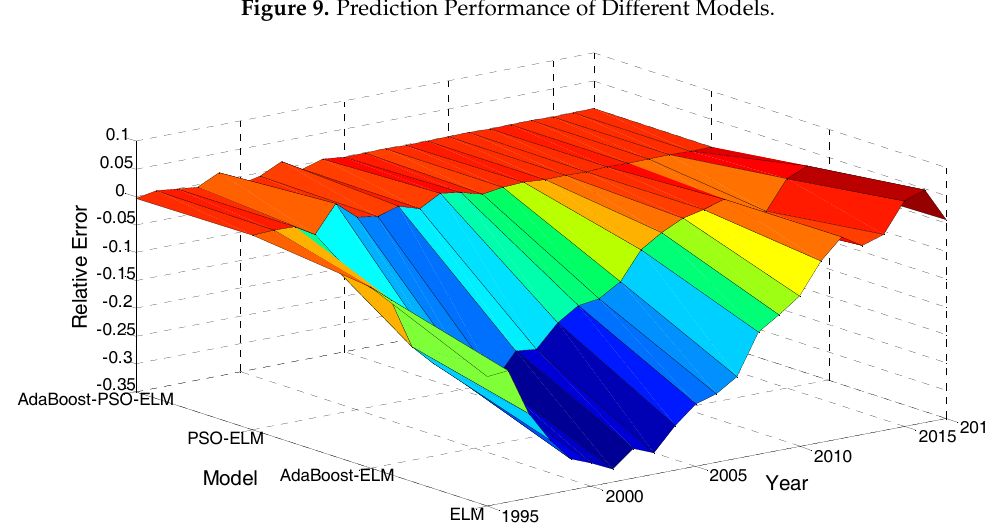
Figure 10. Relative Error of Different Models.